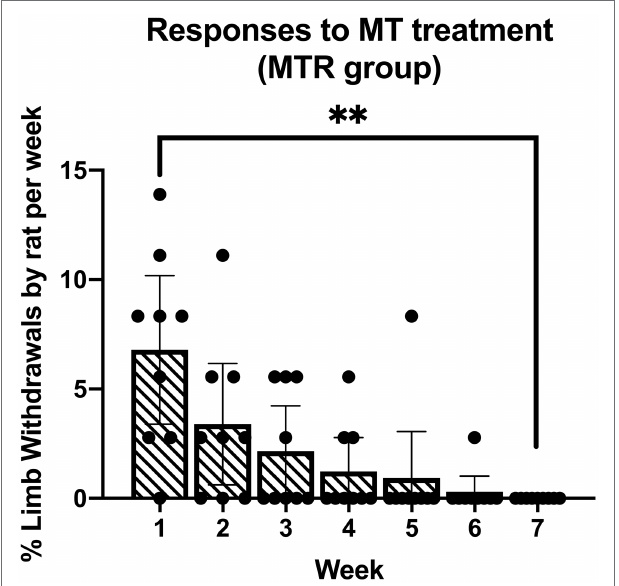
FIGURE 1 | Responses of the manual therapy with rest (MTR) rats to the manual therapy across 7 weeks of treatment. The mean percent limb withdrawal by rat per week of treatment is presented. ** p < 0.01, compared to week 1 of treatment. Mean ± 95% CI